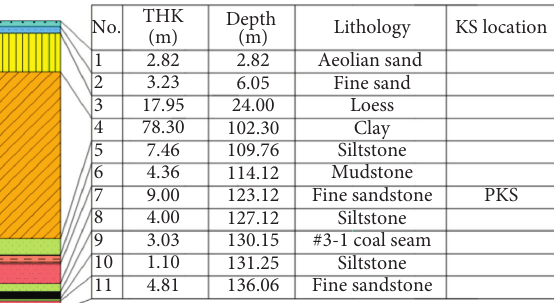
Figure 7: Bore hole columnar section of the coal strata in the Liangshuijing coal mine.